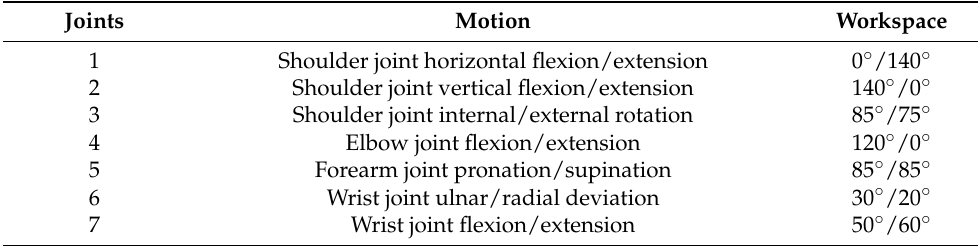
Table A1. Workspace